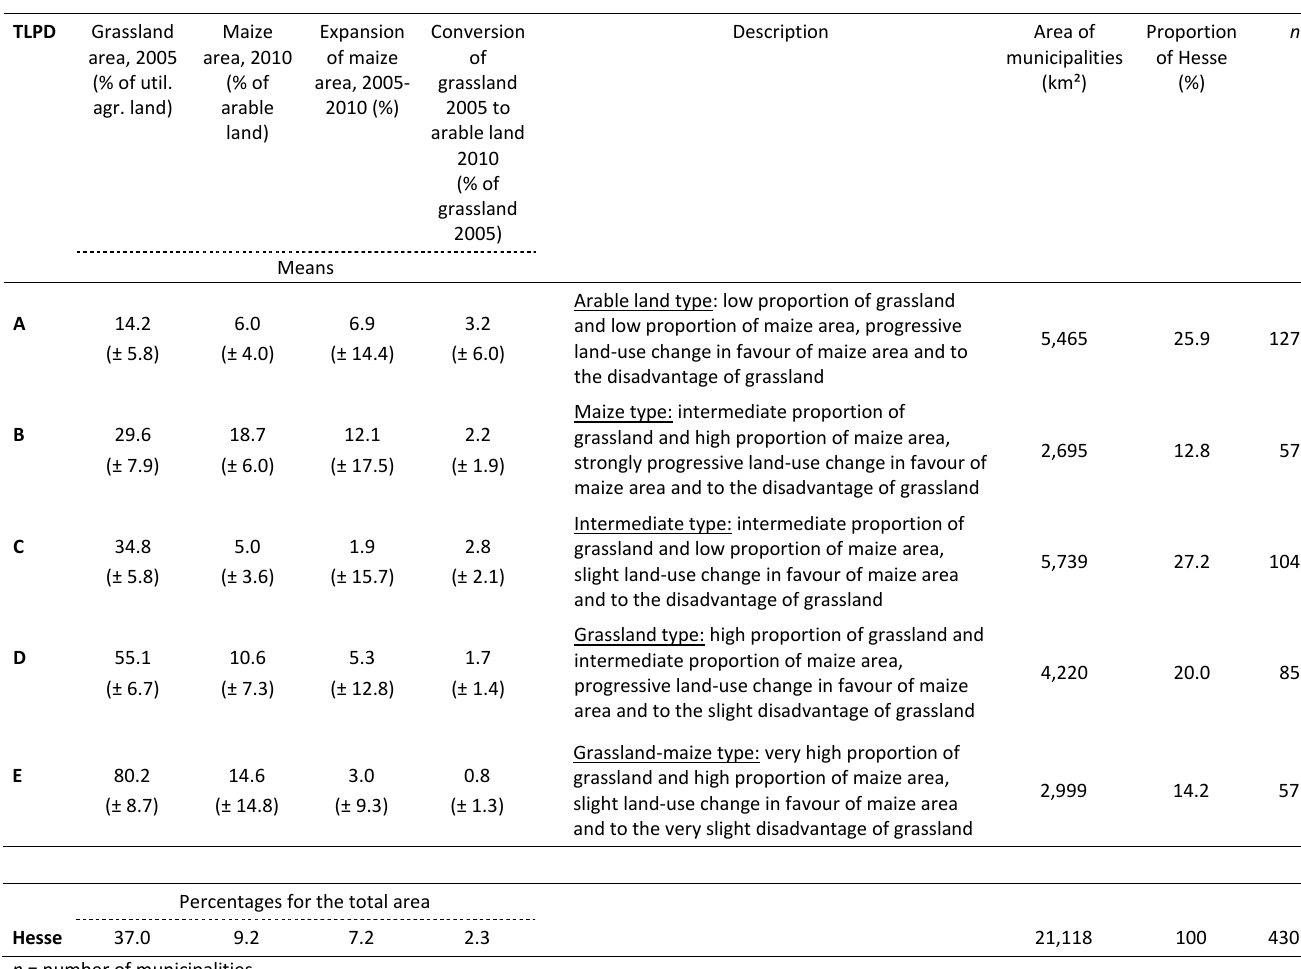
Table 4: Types of agricultural land-use patterns and dynamics (TLPD A-E) characterised by four land-use variables based on IACS data. Results of the k-means cluster analysis are means (with standard deviation). For reasons of comparison, land-use variables of Hesse as a whole are indicated in the last